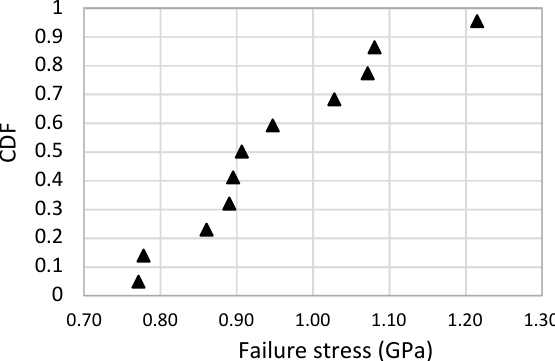
Figure 4. Cumulative distribution function (CDF) curve of polysilicon strength, as obtained with the present experimental campaign.